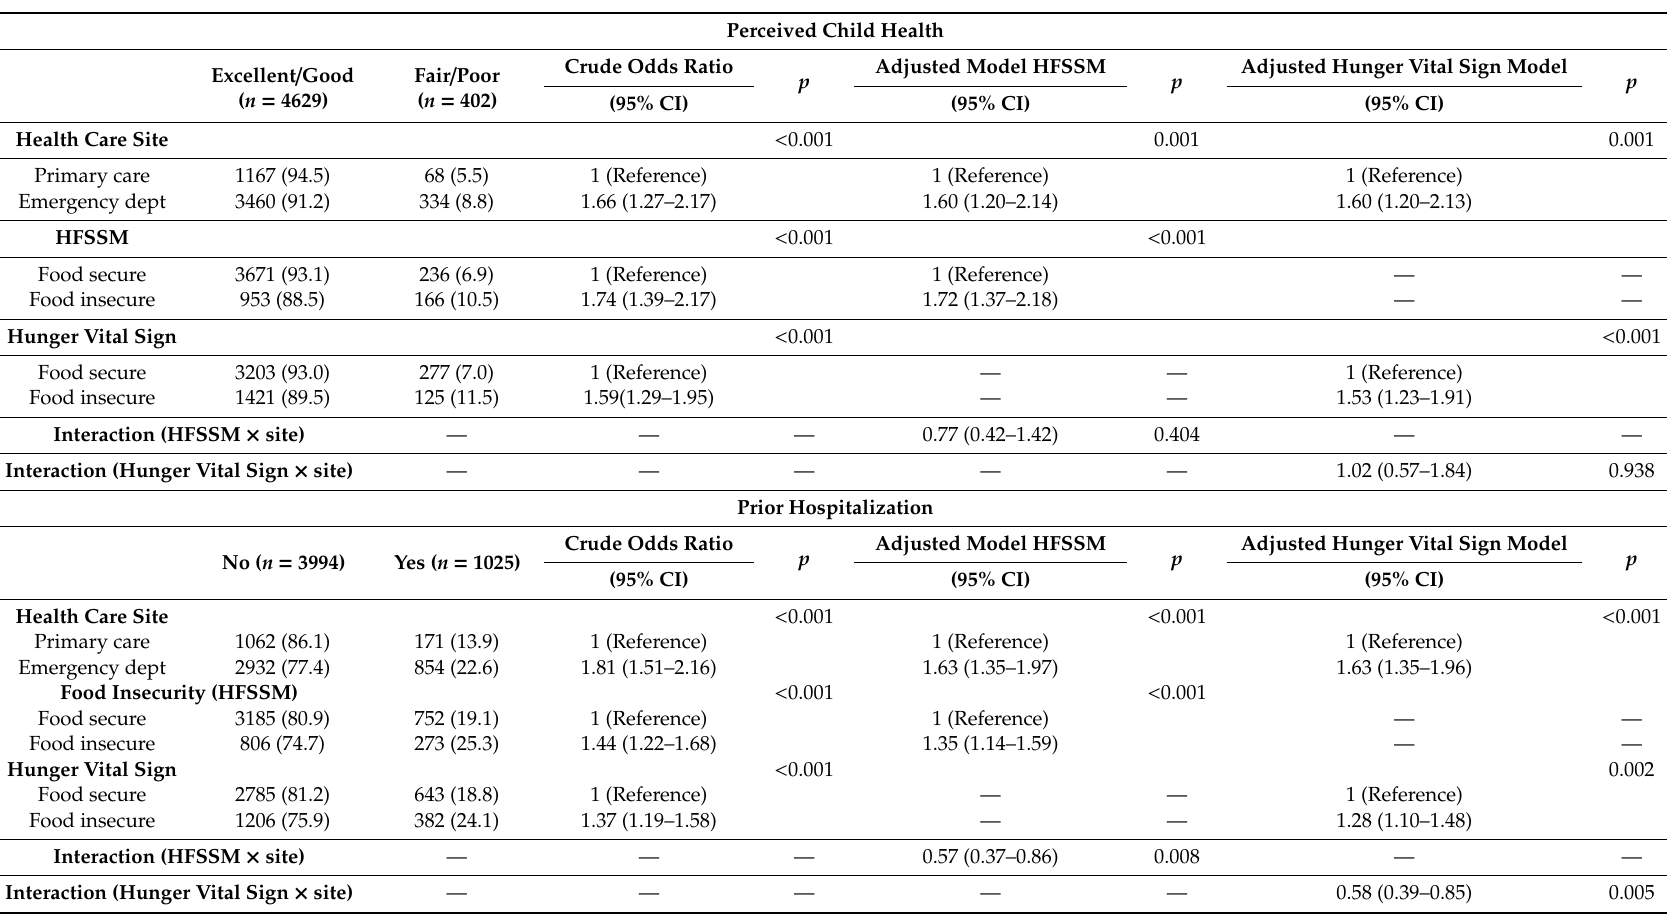
Table 4. Logistic regression of adverse health conditions related to health care site and food insecurity based on HFSSM and Hunger Vital Sign ( n =